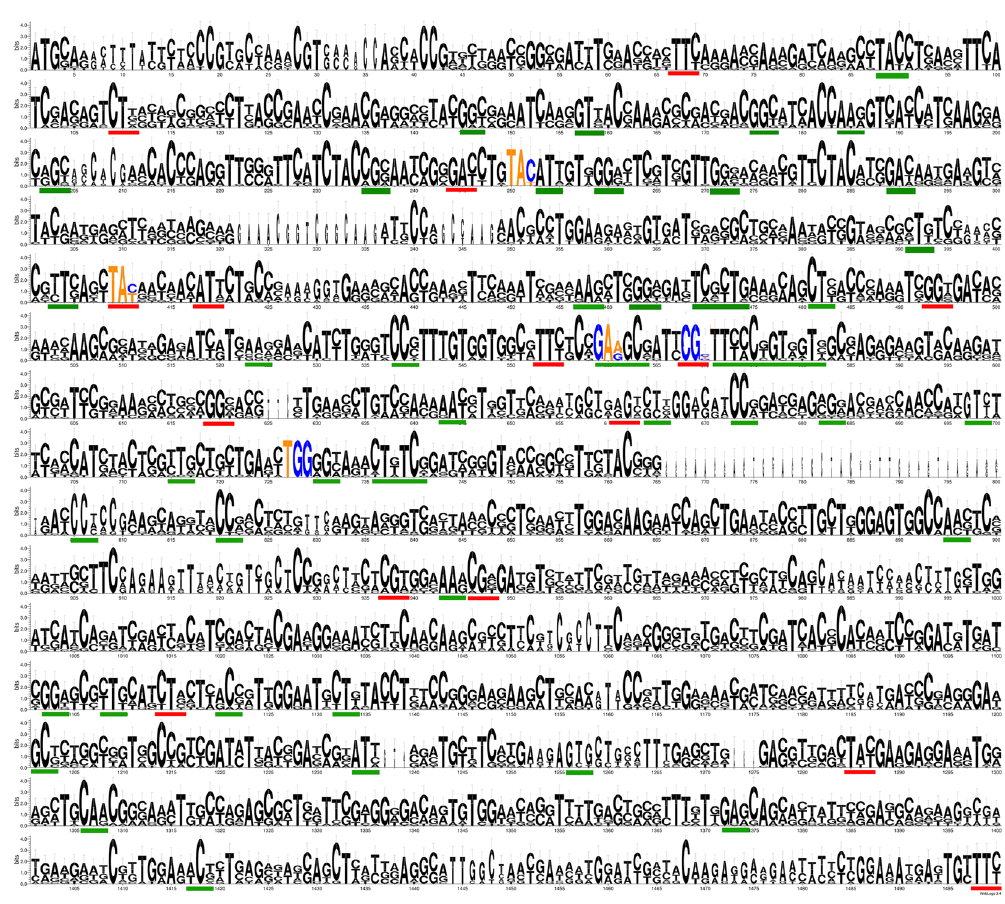
Figure 5. Analyses of the synonymous vs . nonsynonymous substitution rates. Codons forming the active site are indicated by colored nucleotides (A and T: orange, G and C: blue). Codons under significant purifying (negative) selection determined by the three tests (SLAC, FEL and REL), or by two out of the three tests, are underlined in red or green color,